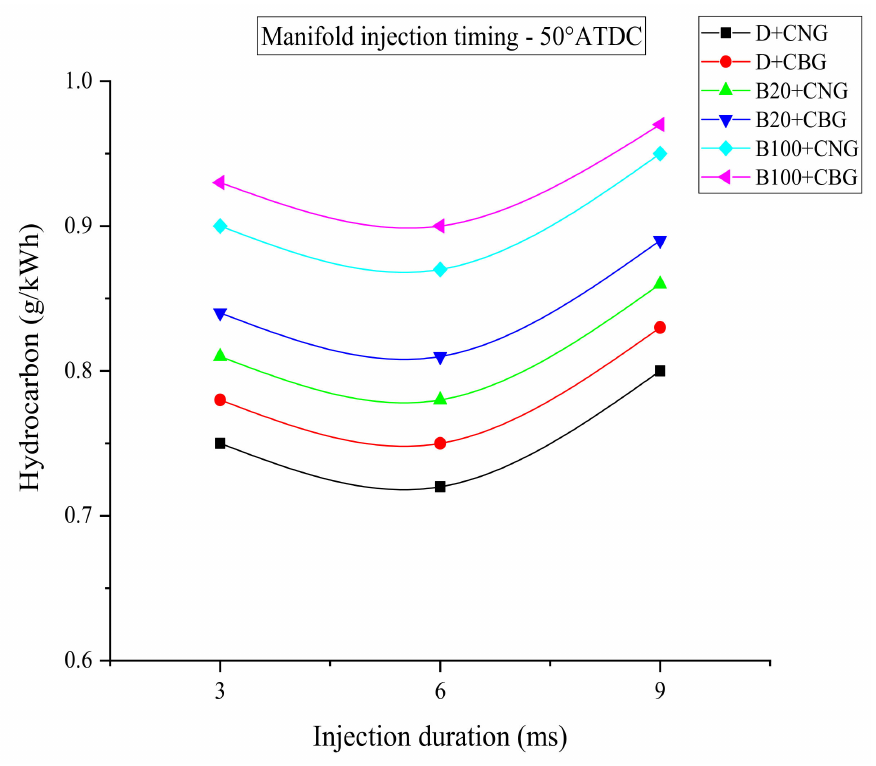
Figure 10. Variation of HC emissions with